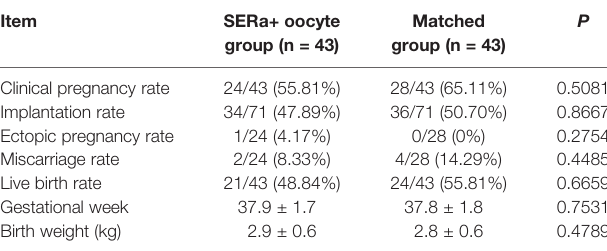
TABLE 4 | Reproductive outcomes of SERa+* oocyte group and the matched group.